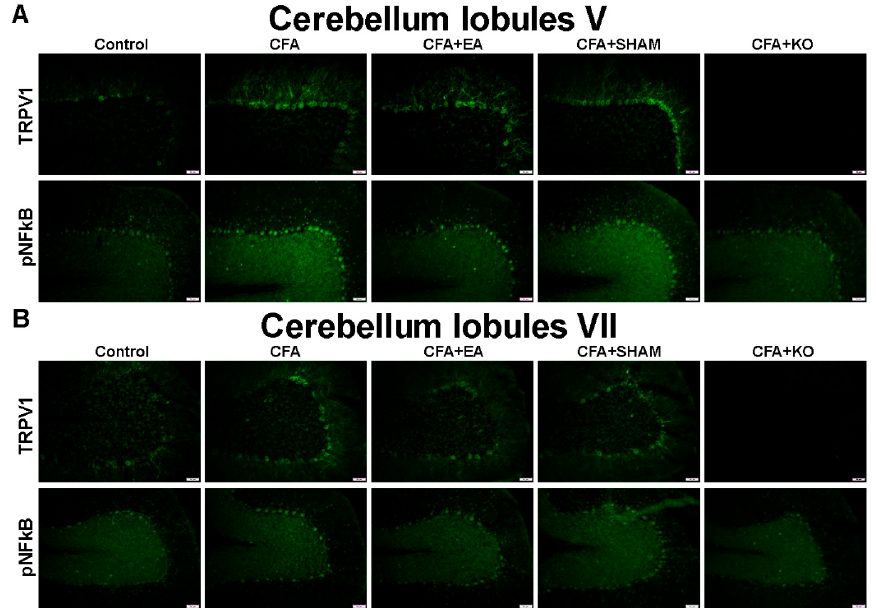
Figure 5. Immunofluorescence staining of TRPV1 and pNFkB protein expression in the cerebellum lobules V and VII. There are 5 subject groups: control, CFA, CFA + EA, CFA + SHAM, and CFA + KO. The effectiveness of EA treatment involves significant reduction of TRPV1 and pNFkB densities in the cerebellum lobules ( A ) V and ( B ) VII. Scale bar is 50 µm.